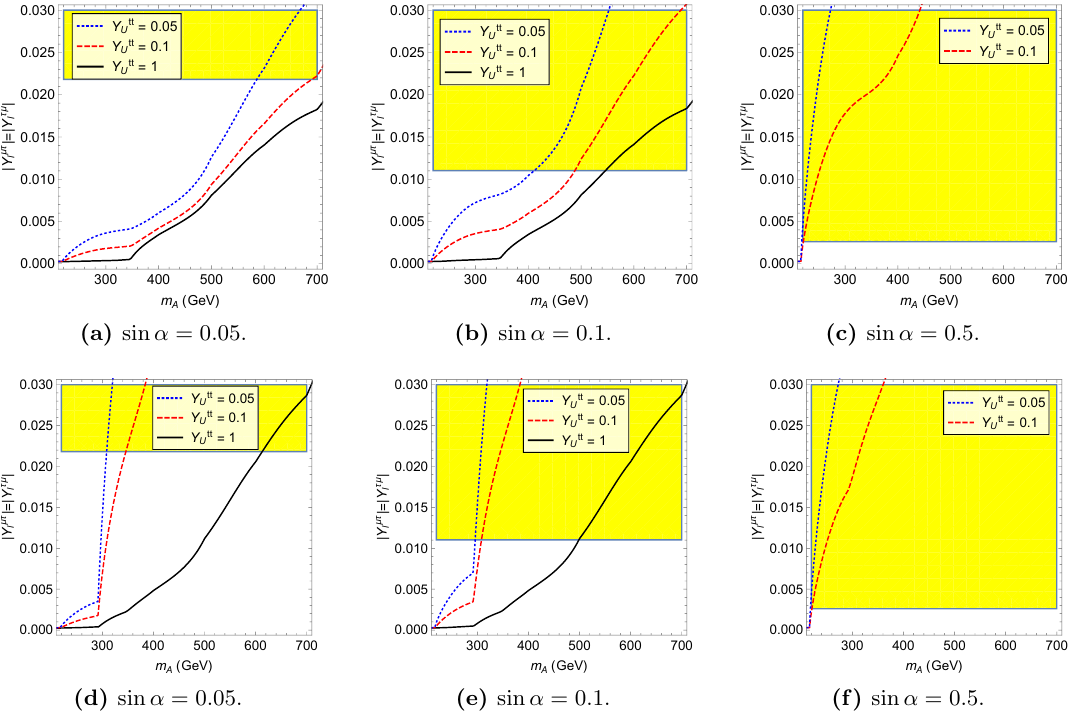
Figure 17. The estimated bounds for the pseudoscalar LFV searches and their comparisons with the h LFV searches for sin (cid:11) = 0 : 05 ; 0 : 1 ; 0 : 5 and Y tt A HZ is closed ( m A < m H + m Z ) while in the bottom pane the decay A ! ( m H = 200 GeV). The yellow region is excluded by the h LFV search. The region above the red, blue and black lines are excluded by the pseudoscalar LFV